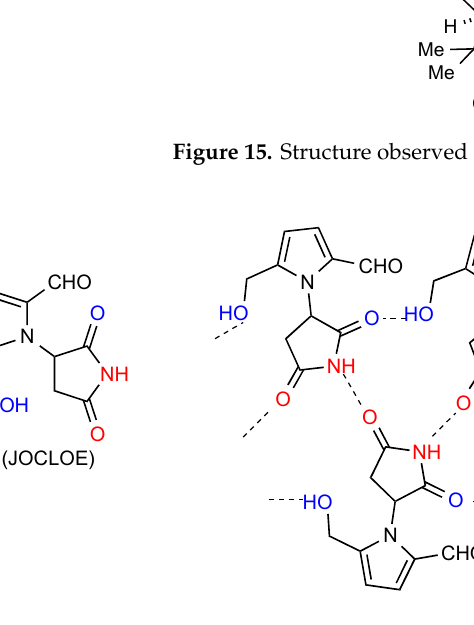
Figure 15. Structure observed for compound 42.